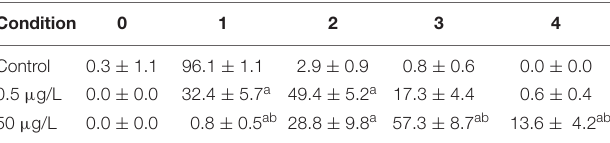
TABLE 3 | Mean frequencies (%) of damaged nucleoid classes’ ± standard error (SE).